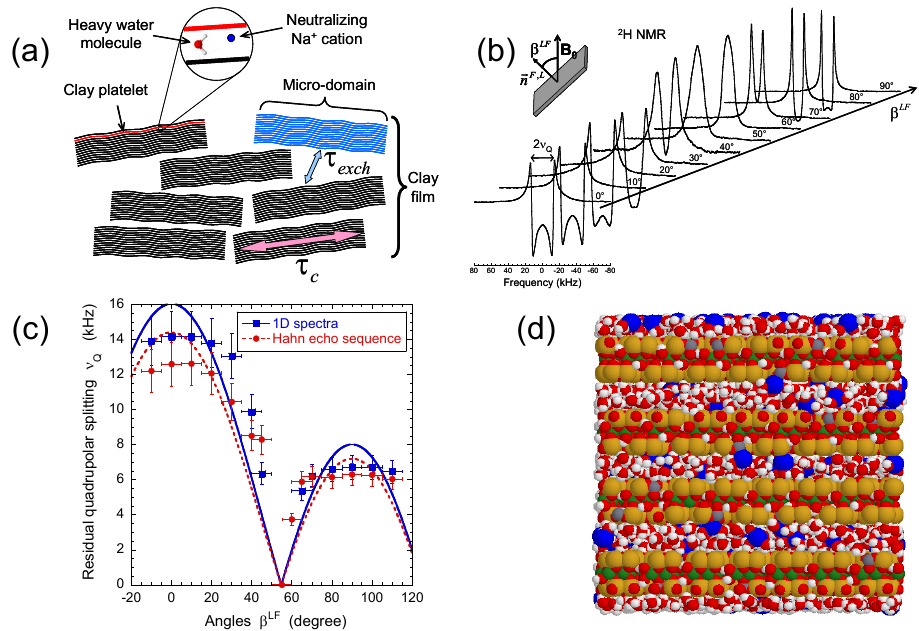
Figure 6. ( a ) Schematic view of the multi-scale organization of the hydrated clay-sediment in- duced by the coexistence of various micro-domains resulting from the stacking of hydrated clay platelets; ( b ) variation of the 2 H NMR spectra of the confined water molecules as a function of the sediment orientation in the static magnetic field; ( c ) variation of the residual quadrupolar split- ting (see Equation (5)), extracted from the spectra displayed in Figure 6b; ( d ) snapshot illustrating one equilibrium configuration obtained by Grand Canonical Monte Carlo simulations of the wa- ter molecules and neutralizing Na + counterions confined between fragments of saponite platelets. Reprinted with permission from Ref. [80]. Copyright (2014) American Chemical